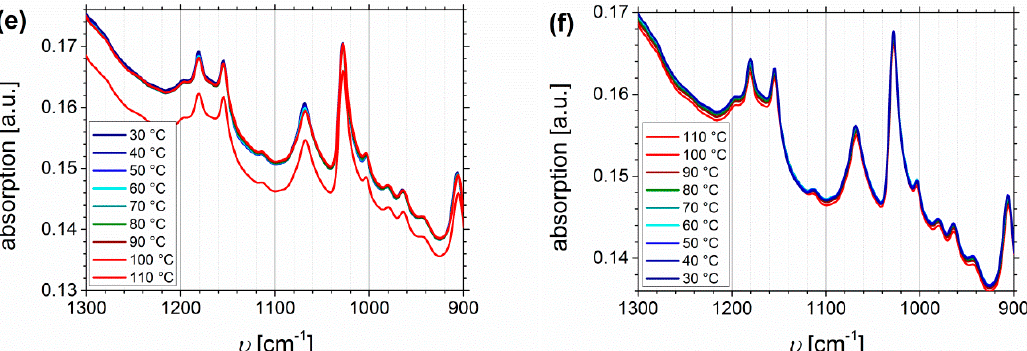
Figure 12. Temperature dependent FTIR spectra of I 1.5 S 96.1 I 2.482 ‐ SA ( D f = 33%). Temperature range was 30 to 110 to 30 °C with 10 °C steps, and a 15 min isothermal hold at each temperature (( a , c,e ): Heating curves; ( b , d , f ): Cooling curves).